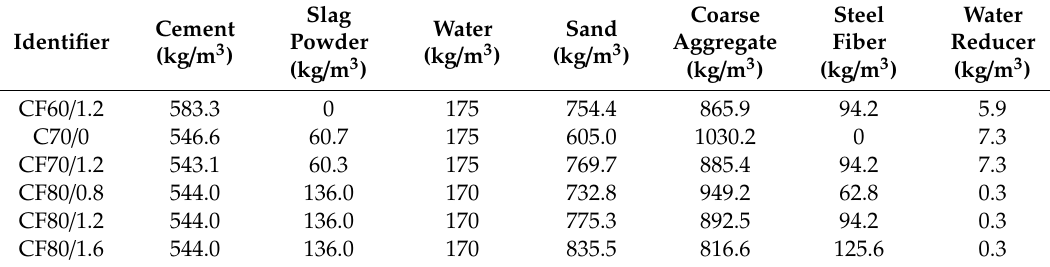
Table 1. Mix proportions of normal concrete and steel fiber reinforced concrete